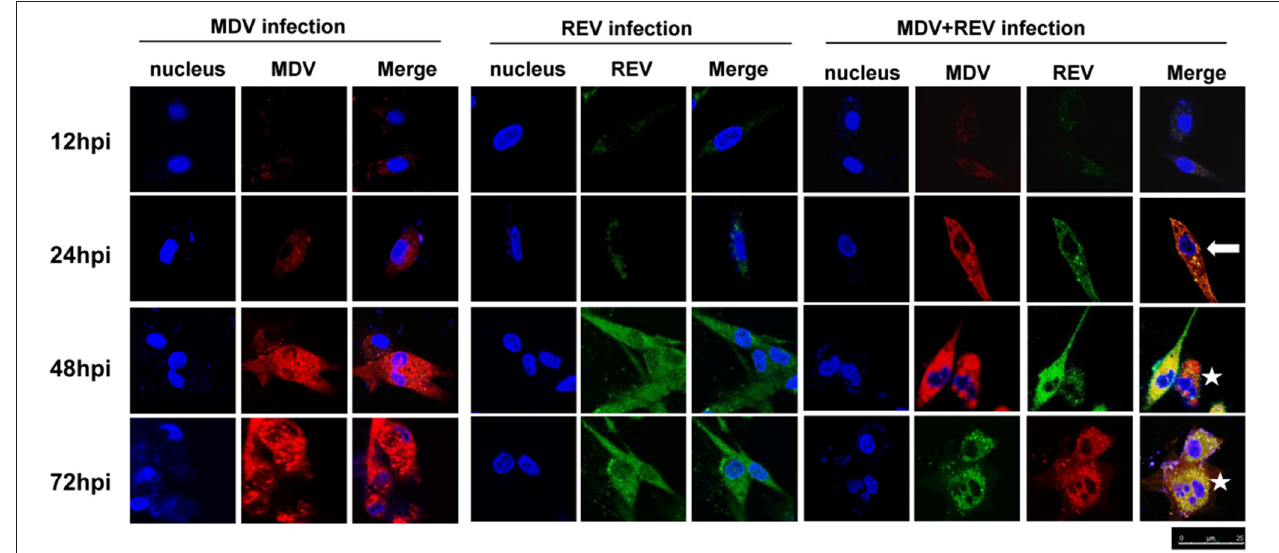
FIGURE 2 | Protein expression and localization of MDV and REV examined by confocal laser scanning microscope (CLSM). The proteins of MDV and REV were co-localized in cytoplasm (arrowhead). The coinfected cells showed more cytopathy (CPE) (star) than single-infected cells. Samples stained with pp38 or gp90 antibodies as well as Cy3-labeled goat anti-rabbit IgG (for MDV) (red) or FITC-labeled goat anti-mouse IgG (for REV) (green) antibody in the assay. The areas of colocalization are shown in yellow. Cell nuclei (blue) were stained with DAPI. MDV, Marek’s disease virus; REV, reticuloendotheliosis virus; CLSM, confocal laser scanning microscope; CPE, cytopathic effect; FITC, fluorescein